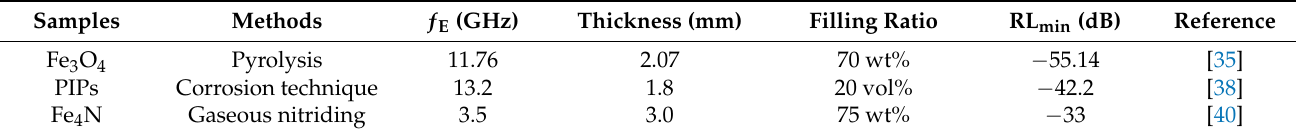
Table 1. The electromagnetic absorption performance of sphere-like